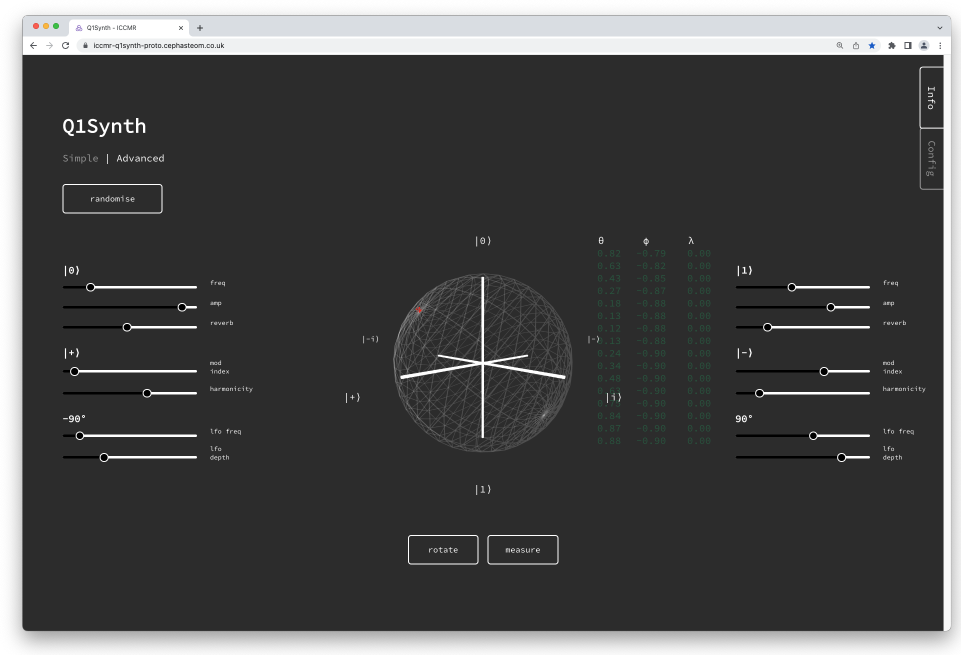
Figure 6. A screenshot of the Q1Synth in ‘Advanced’ mode. In contrast to the ‘Simple’ mode, in ‘Advanced’ mode the system provides options to adjust the range of the synthesis